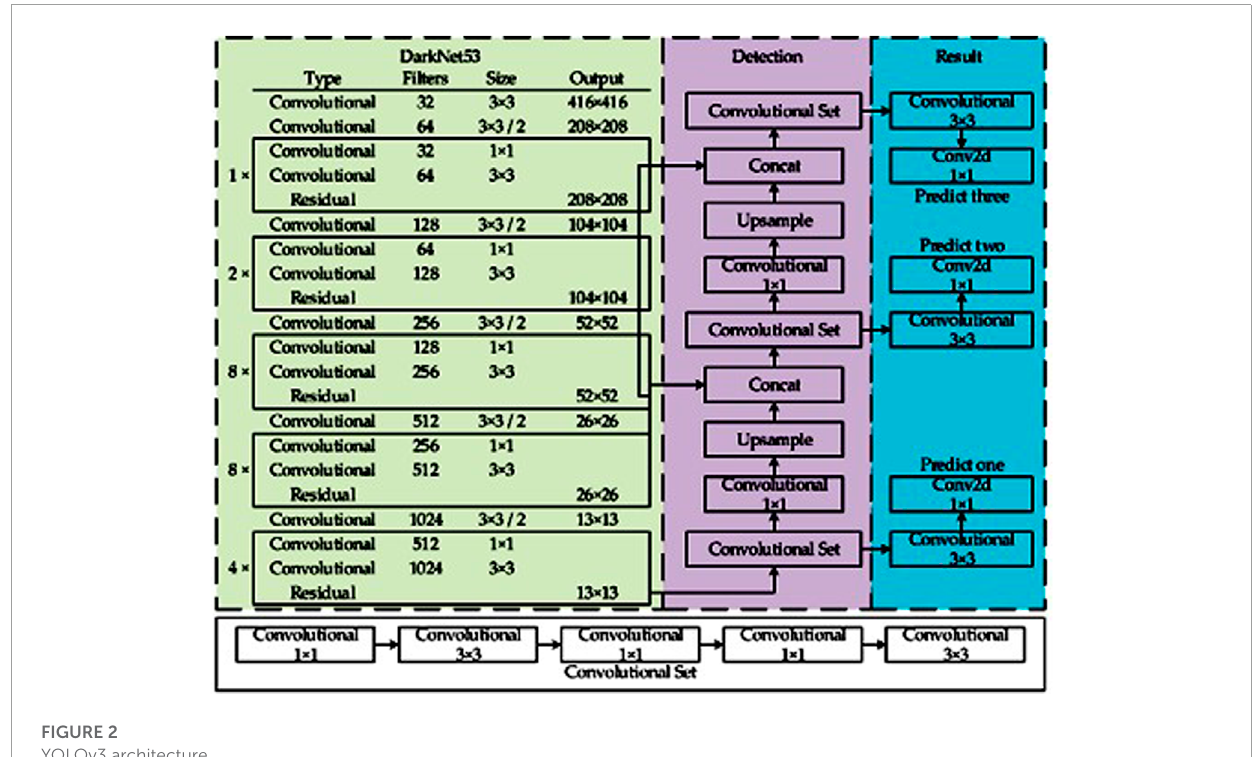
FIGURE 2 YOLOv3 architecture.